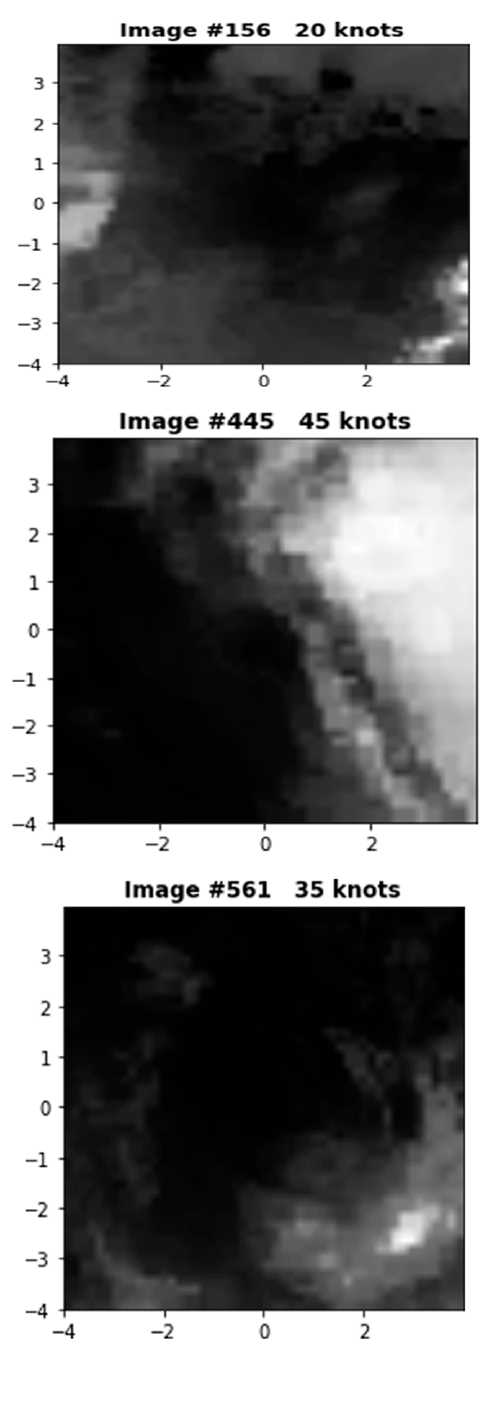
Figure 12. Absolute errors of different hurricane categories.